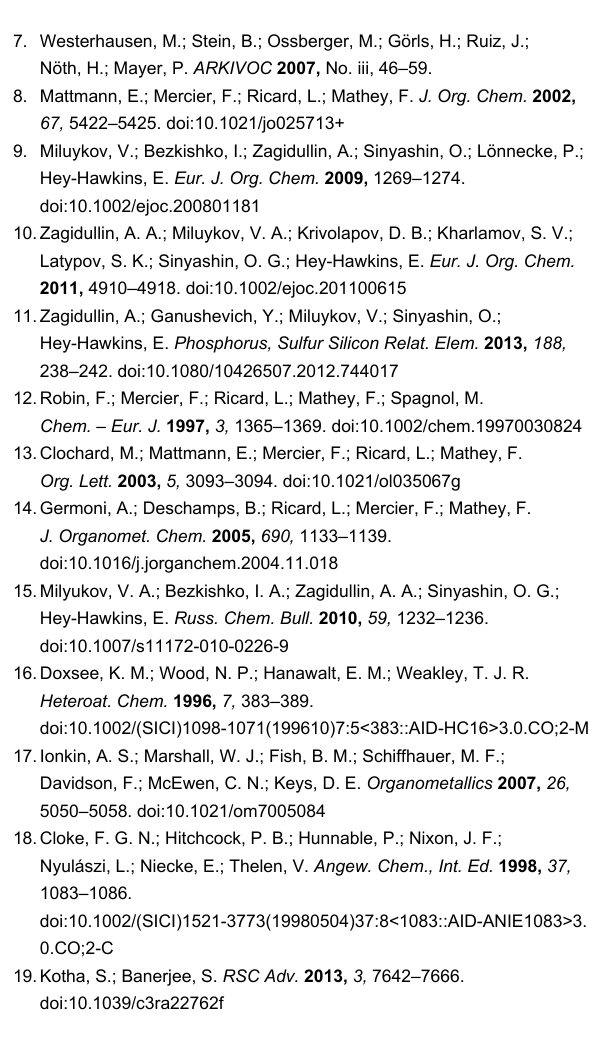
Scheme 3: The retro-Diels–Alder reactions of the cycloadducts 2a– с , and 2e .